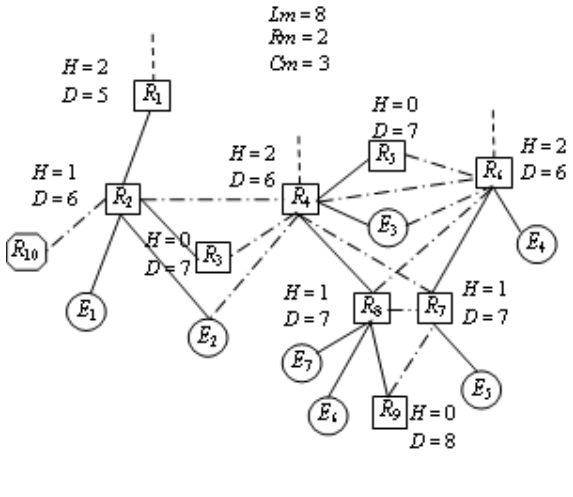
Figure 5. A part of a ZigBee